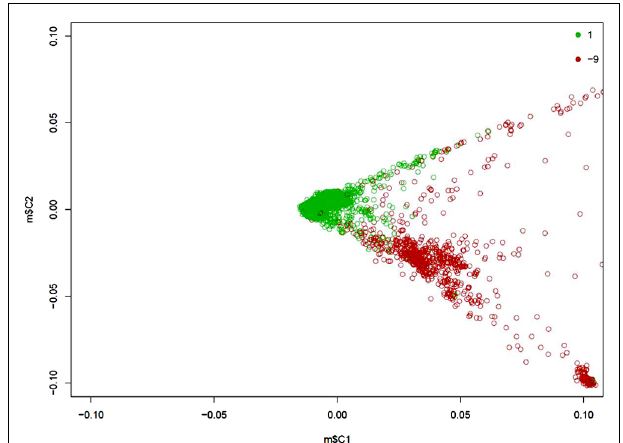
FIGURE 1 |Two-dimensional MDS plot of theAGP population .The green circles are Caucasian individuals; the red circles are those of other ethnicities.